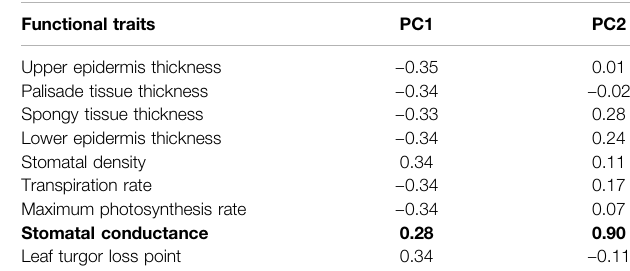
Table 2 | The fi rst two axes of a principal component analysis (PCA) for Bombax ceiba and Bridelia tomentosa , based on nine plant traits. Bold indicates signi fi